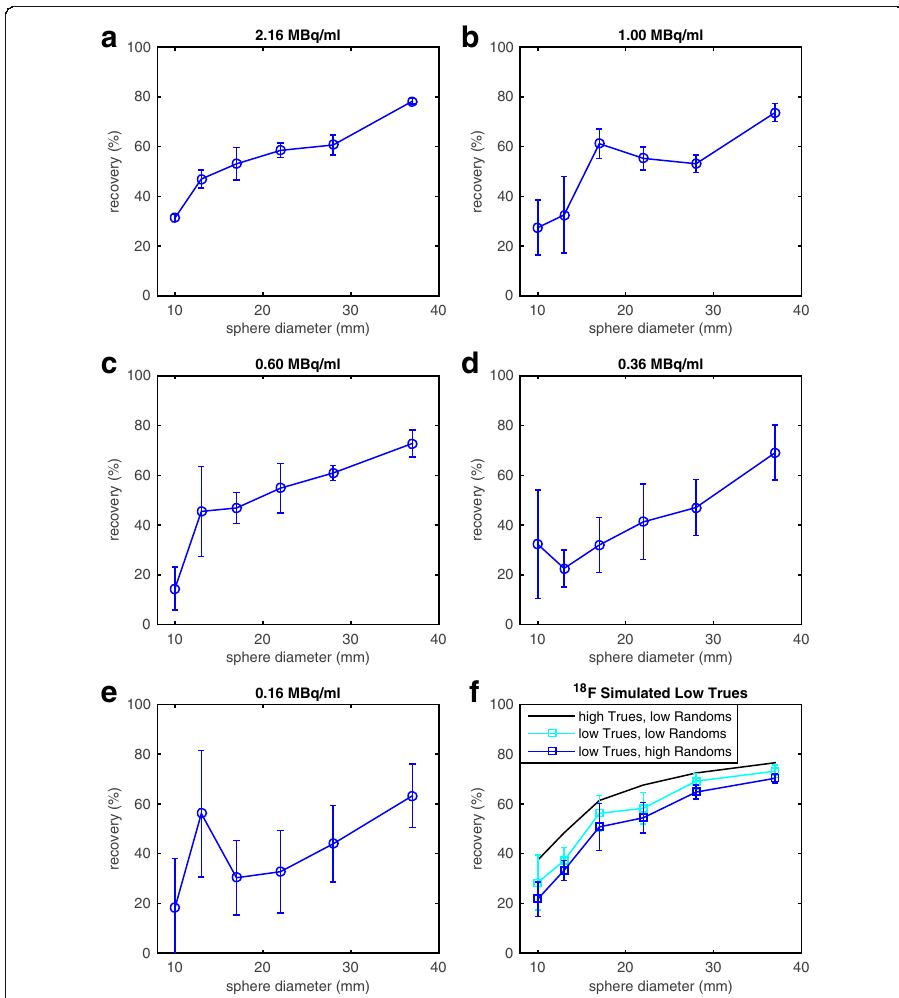
Fig. 6 a – e Recovery coefficients as a function of hot sphere size from three consecutive scans at a single site. Each point represents the mean RC, and error bars represent one standard deviation. The COV for each sphere size and hot sphere activity concentrations are shown in Table 4. f Measurements from raw 18 F data (black line), 18 F data with similar 90 Y true count statistics (light blue square), and 18 F data with similar true count statistics and randoms fraction to 90 Y. Again, each point represents the mean RC and error bars represent one standard deviation across the ten 3-s 18 F datasets